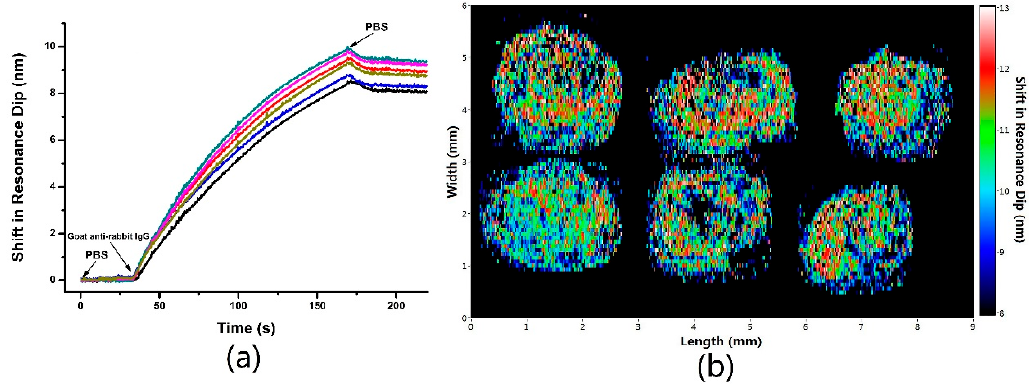
Figure 5. Measurement of antigen-antibody interaction between goat anti-rabbit IgG and rabbit IgG. ( a ) Real-time wavelength response of antigen-antibody binding reaction; ( b ) Image of SPR dip shift.